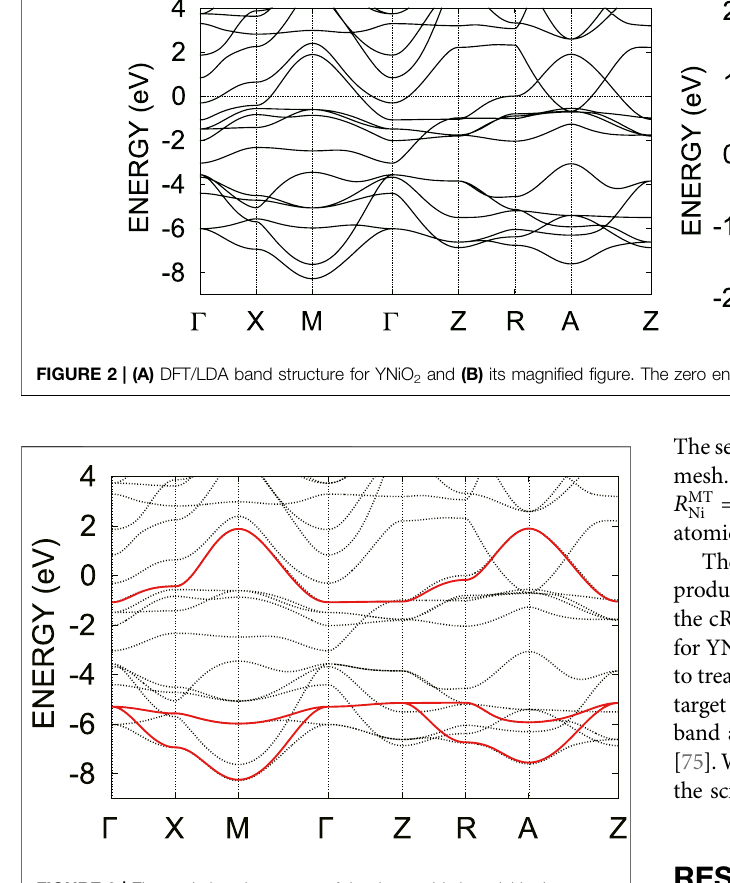
FIGURE 3 | Electronic band structure of the three-orbital model in the LDA (solid lines). The zero energy corresponds to the Fermi level. For comparison, the band structures in the LDA is also given (dotted